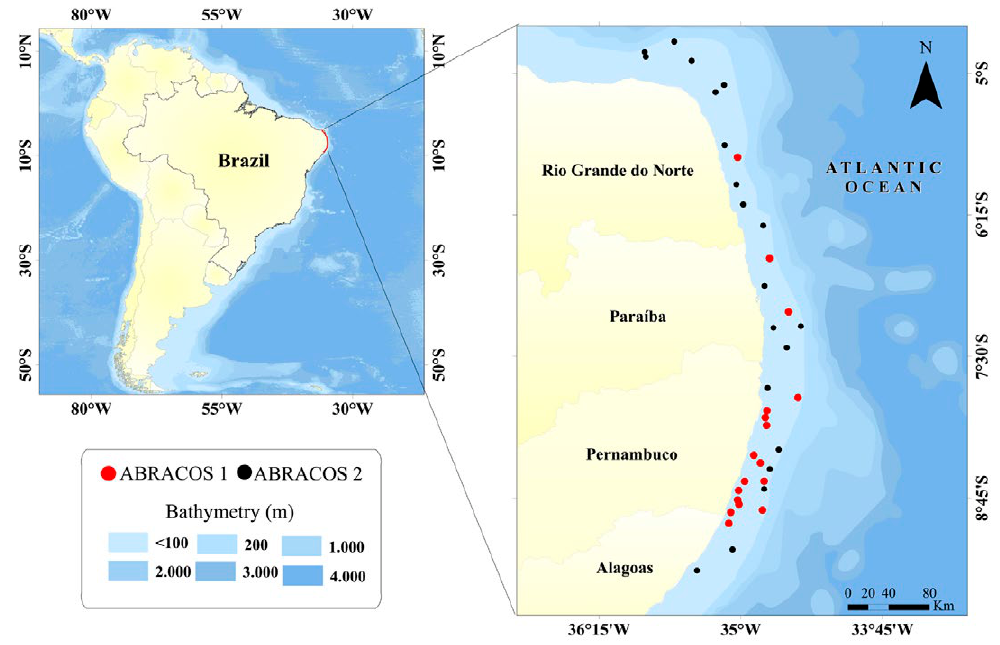
Fig. 1. – Study area with bathymetry and sample points along the continental shelf of the northeast coast of Brazil. Red dots indicate the first ABRACOS survey and black dots indicate the second ABRACOS